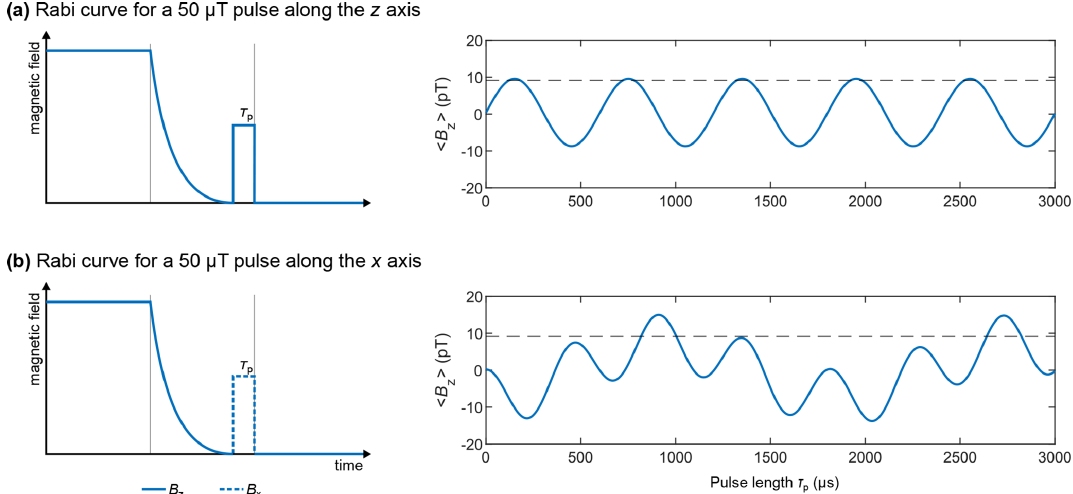
Figure 5. Rabi curves at ZF with excitation pulses along z (a) and x (b) axes applied to an XA spin system. The horizontal dashed line represents the signal integral of the sudden drop ZF experiment. The time domain signal was computed by propagating the density matrix under the effect of the Hamiltonian for a total time of 5s (parameter t aq ), discretized into 4096 points (parameter K ), and corresponding to time intervals d t of 1.2207ms (parameter τ D ). A monoexponential apodization function was applied to the time domain signal, with a coherence time constant T 2 of 1s. The apodized time domain signal was Fourier transformed with zero-filling to 65536 points. The frequency domain signal was then integrated from 138 to 142Hz. The Rabi curve represents the integral compared with the excitation pulse